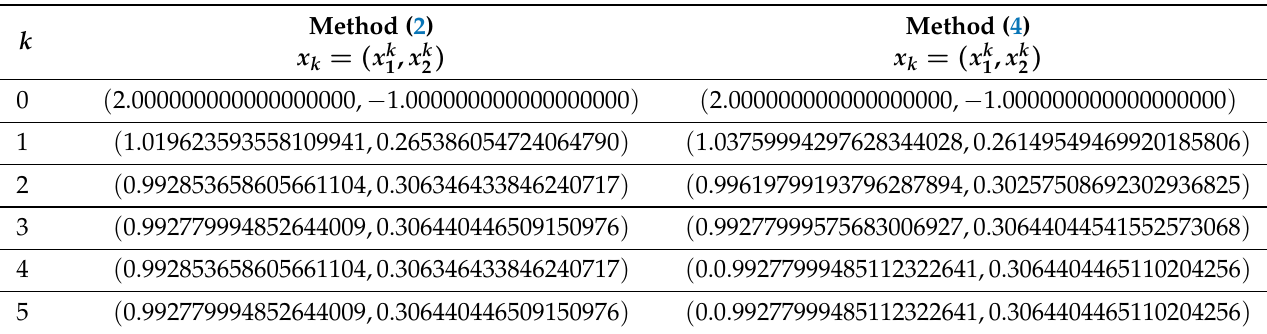
Table 2. Method (2) and Method